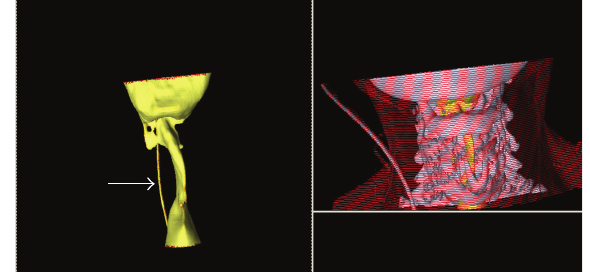
Figure 2: Three dimensional CT reconstruction of the larynx, yellow structures are air. Gray areas are bony structures. There is narrowing of the airway of 4 mm over a 4cm long trajectory at the subglottic level. White arrow: reconstruction of air column in the feeding tube which is present in the